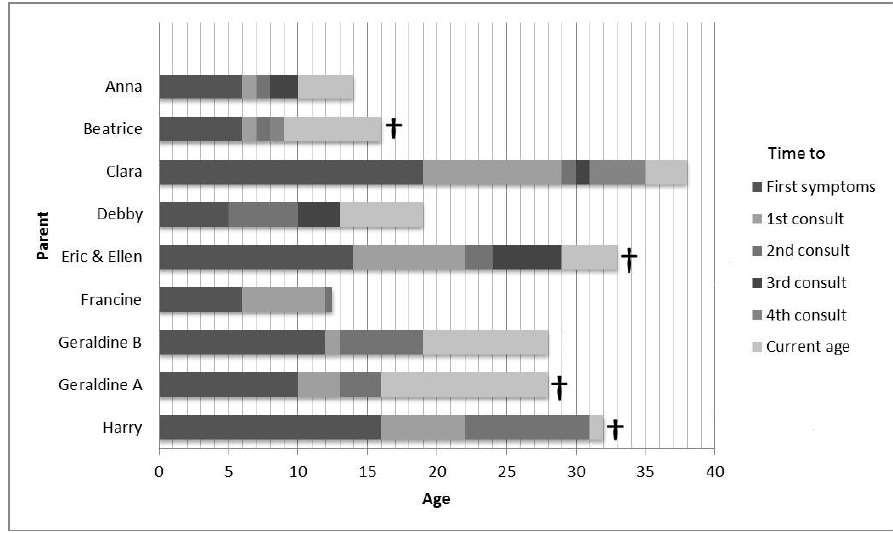
Figure 1. Diagnostic process timeline. † = death.